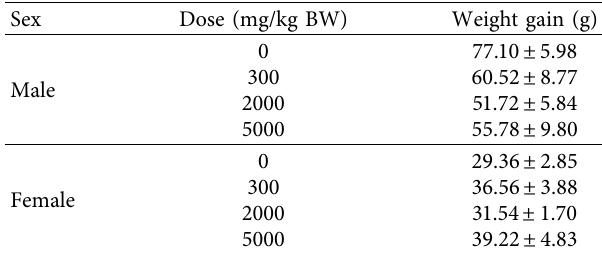
NC: normal control, DC: diabetic control, CHOL: cholesterol, HDL: high-density lipoprotein, LDL: low-density lipoprotein, TG: triglyceride. Results are expressed as mean ± SEM ( n � 5). ( a ) means significantly different from NC group; ( b ) means significantly different from DC group; ( c ) means significantly different from DC+acarbose group; ( d ) means significantly different from DC+200mg/kg EEAC group ( p < 0 . 05). Table 5: Body weight changes of experimental animals after 14 days of single oral administration of different doses of EEAC from acute toxicity